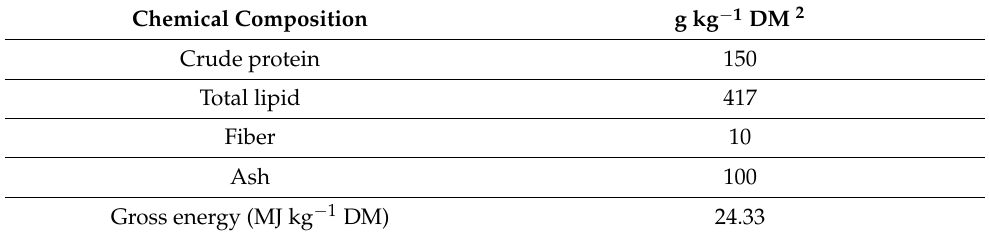
Table 1. Chemical composition of the Schizochytrium sp. used in this experiment 1 . Chemical Composition